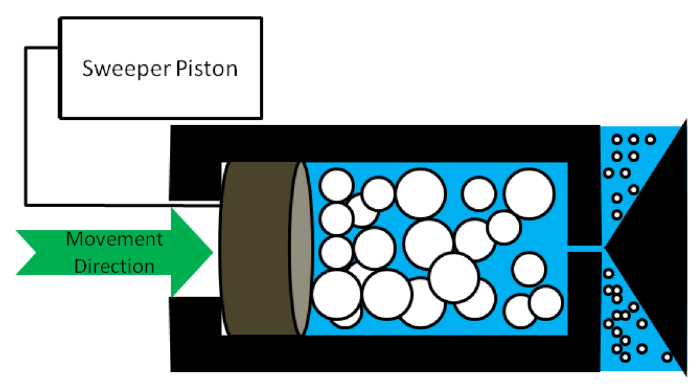
Fig. 4 Operation of a high- pressure